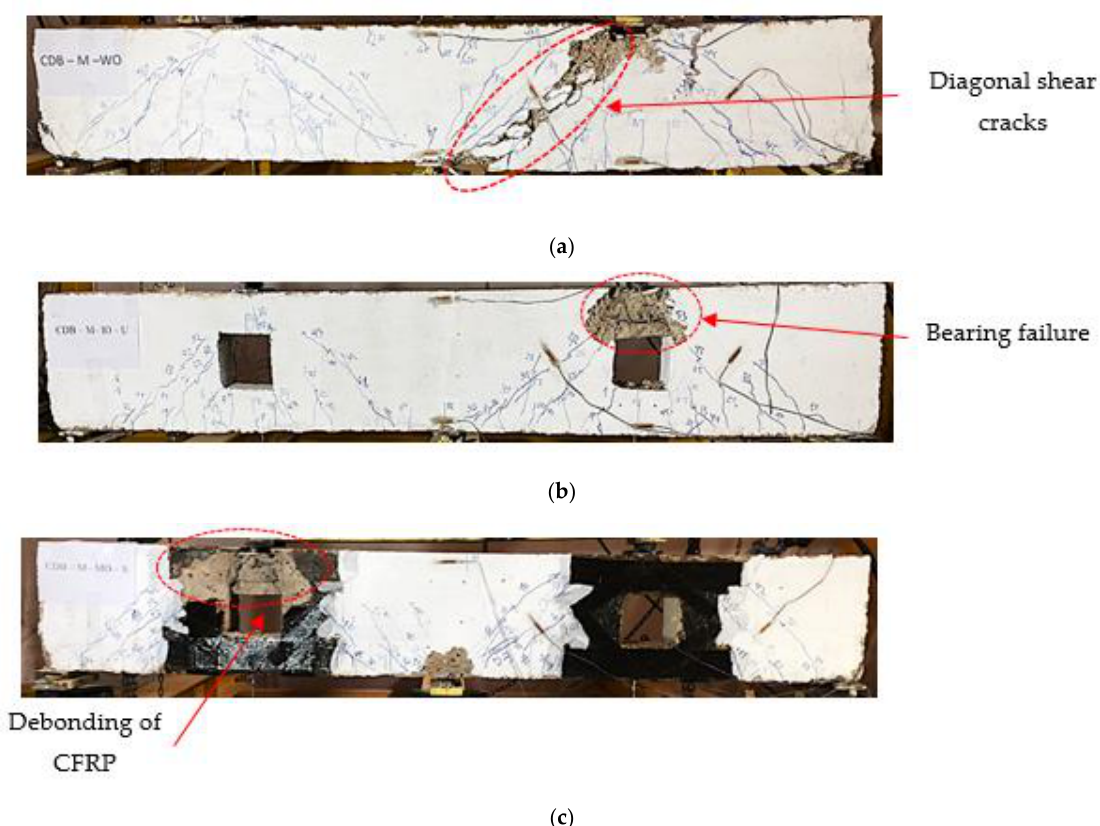
Figure 6. Modes of failure for the tested specimens. ( a ) Specimen CDB–Solid; ( b ) Specimen CDB–O–U; ( c ) Specimen